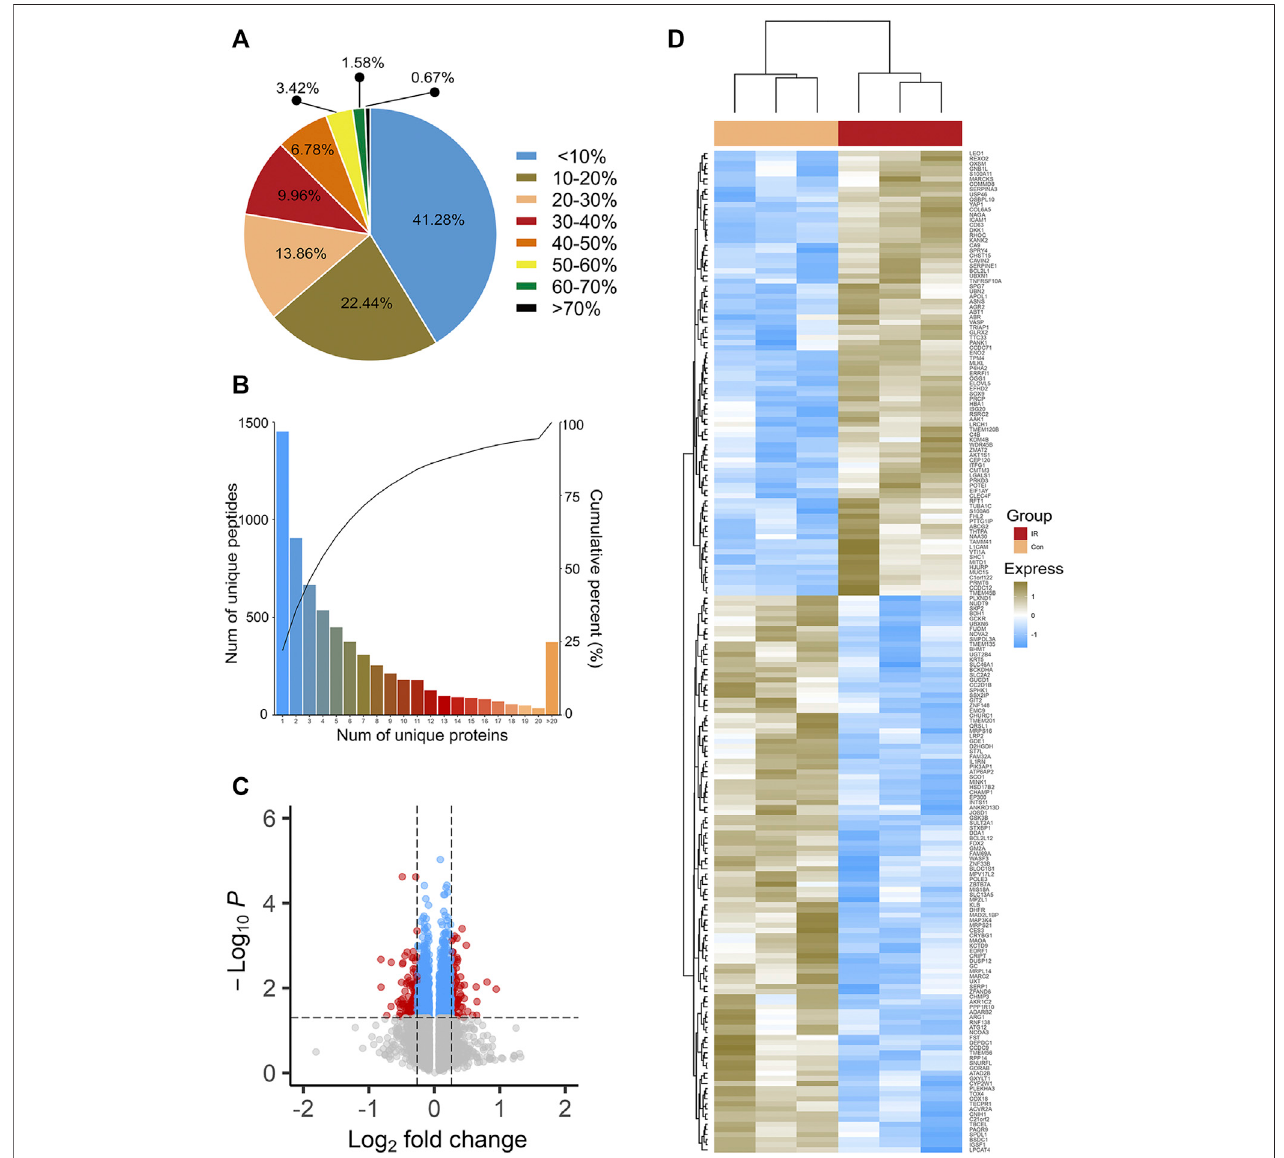
FIGURE1| Sequencecoveragedistribution (A) anduniquepeptidesnumberdistribution (B) ofproteins. (C) isthevolcanoplotsofInsulinresistantHepG2cells(IR) vs its parental HepG2 cells (CON). The most statistically signi fi cant proteins were displayed at the top of area, with upregulated proteins in red dots and downregulated proteins in green dots. Black dots represent no signi fi cant differences. (D) is the hierarchy clustering results expressed in tree heat maps.